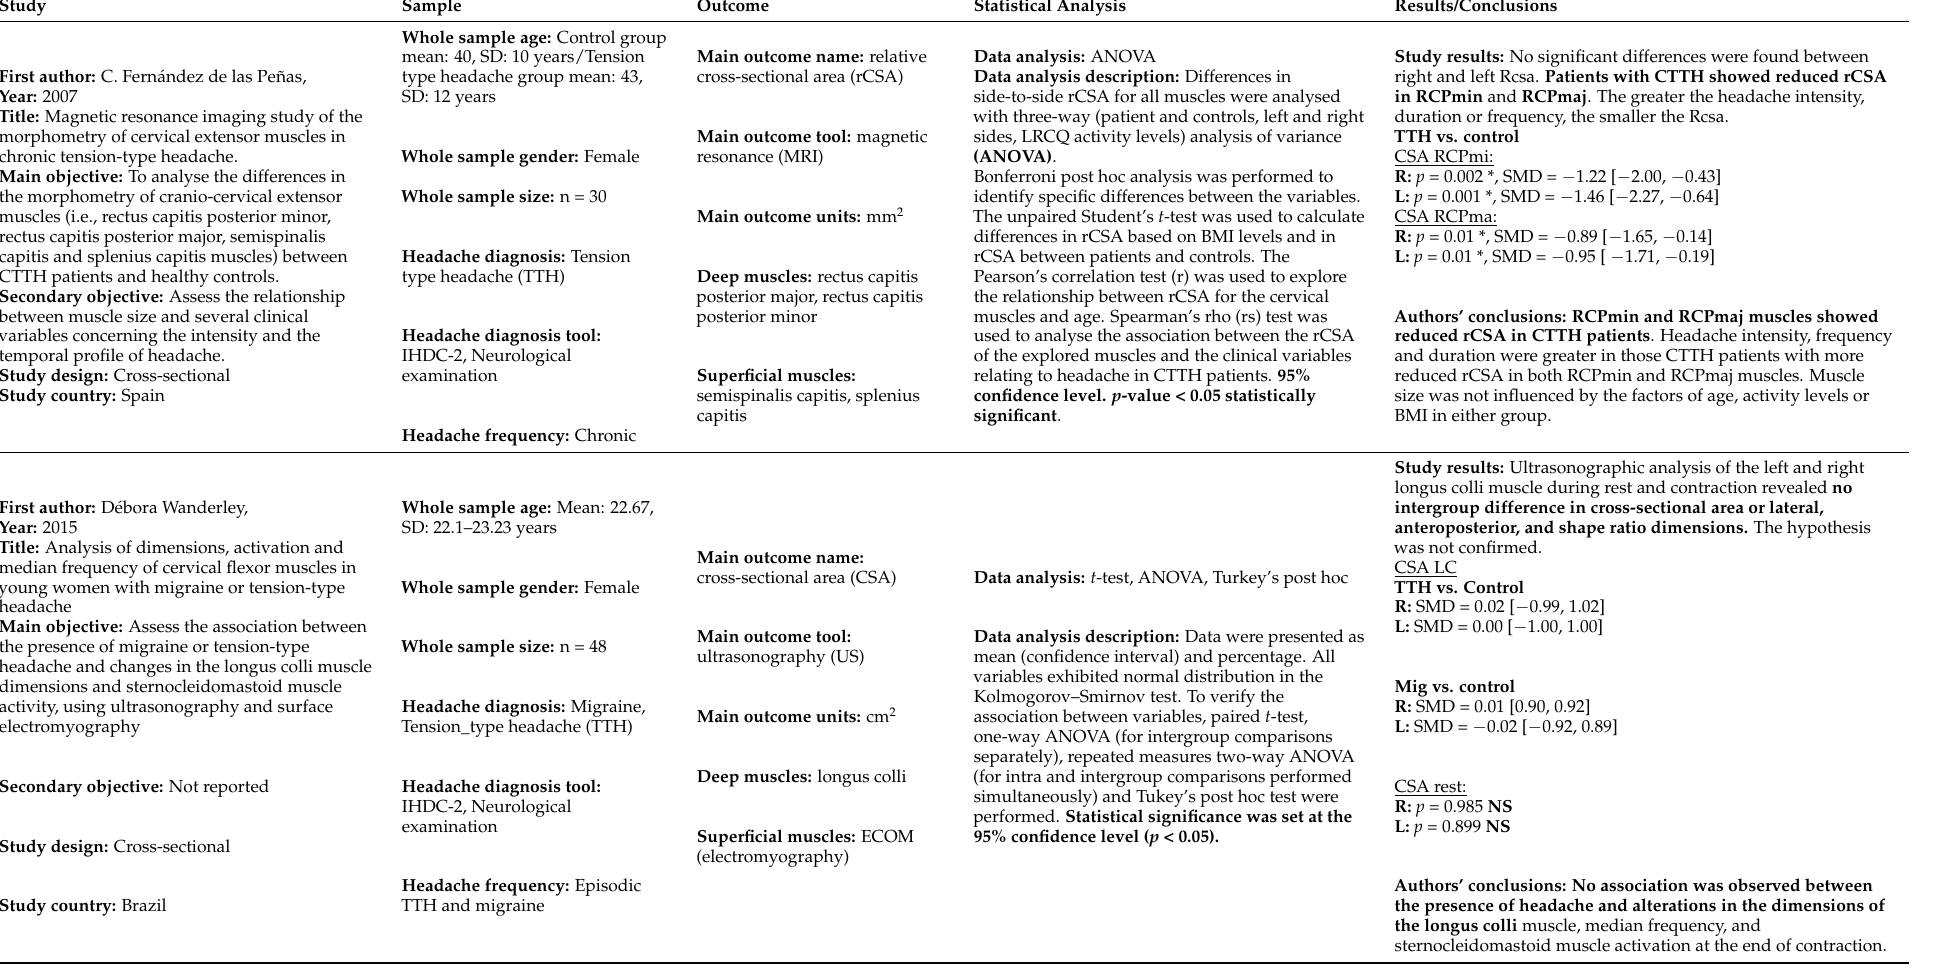
Table A4. Summary of the main characteristics of the five observational studies included in this systematic review. Sample